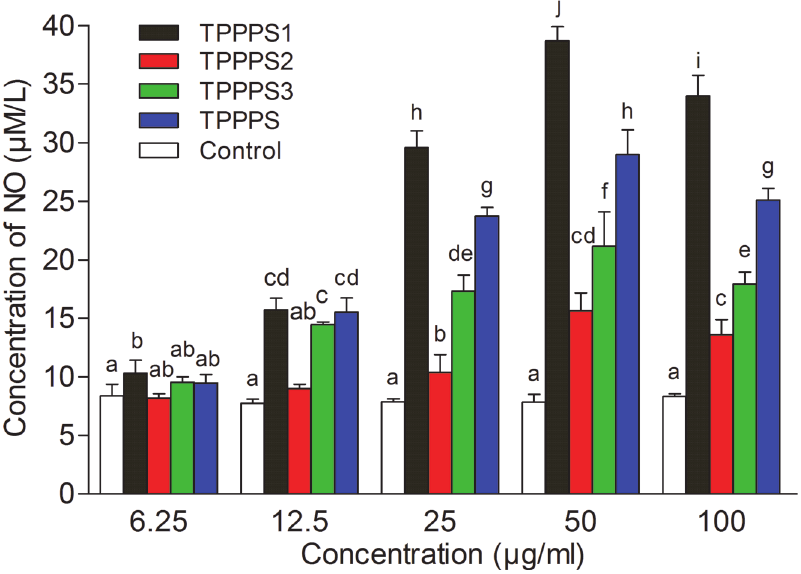
Fig 5. Effects of TPPPS1-3 and TPPPS on production of NO in vitro . The supernatant in 96-well plates cultured with splenocytes were collected. NO production was measured spectrophotometrically using the Griess reaction. PBS treatment wells served as the control, and the values are presented as mean ± SD from five independent experiments. Different superscripts indicate a significant difference ( P < 0.05).